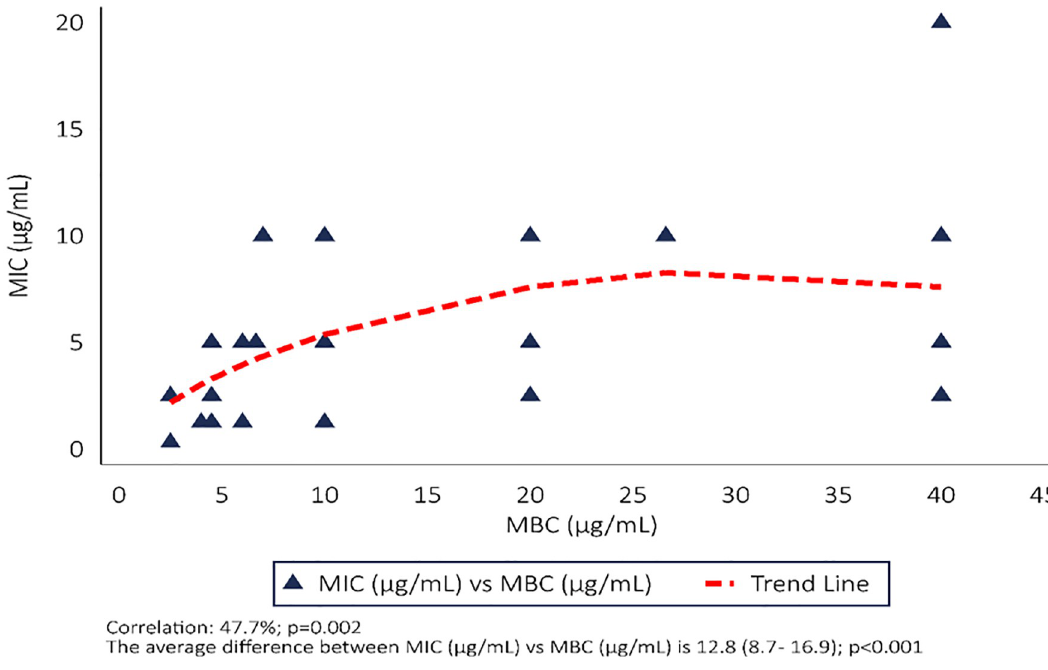
Fig 3. MIC and MBCs of TR in 39 drug-resistant isolates of M . tuberculosis